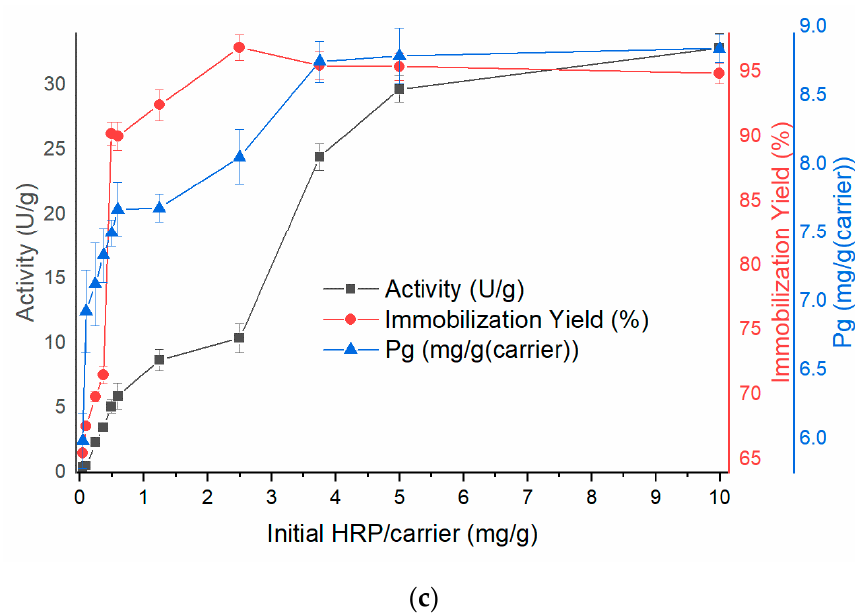
Figure 6. Effects of ( a ) HRP-MAB size (initial HRP/carrier ratio 10 mg/g, Mag-alginate ratio 1:4); ( b ) Mag-alginate ratio (initial HRP/carrier ratio 2.5 mg/g, bead diameter 1.03 mm); and ( c ) initial HRP/carrier ratio (bead diameter 1.03 mm, Mag-alginate ratio 1:4) on the immobilization yield (red y-axis, line and circle), protein loading (blue y-axis, line and triangle) and activity in the standard assay (black y-axis, line and square).